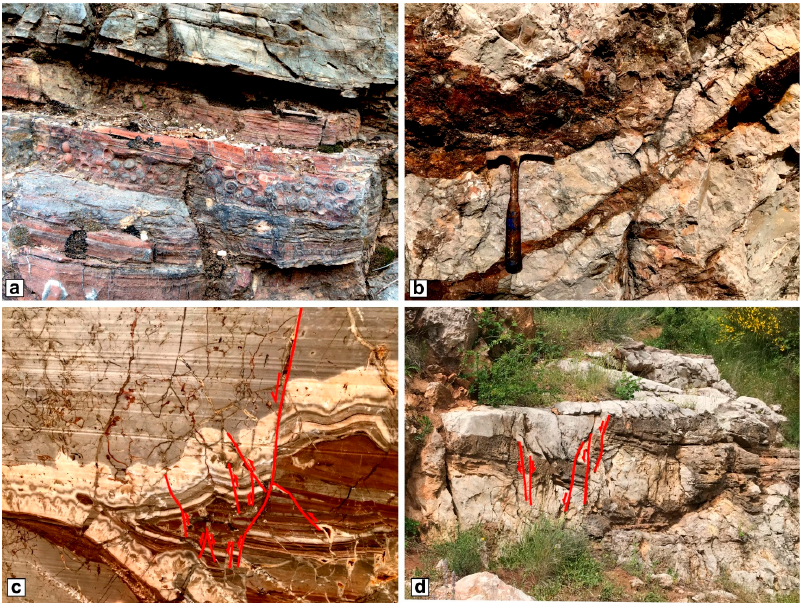
Figure 2. Examples of bauxite occurrence in the study area: ( a ) karst cavity filled by calcareous deposits hosting bauxitic pisolites (Colle Noce); ( b ) fractures filled by bauxite (Uria quarry); ( c ) karst cavity filled by calcite cement and bauxite material (Uria quarry); ( d ) parallel-bedding karst cavity filled by bauxite, hosting syn-sedimentary faults (Uria quarry). Red lines represent the faults, whereas the red arrows indicate the sense of